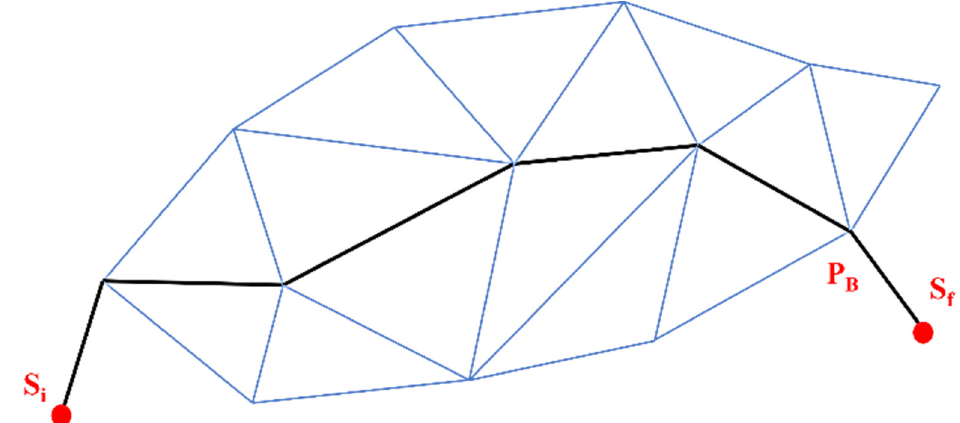
Figure 11. A maximal support path (PS).